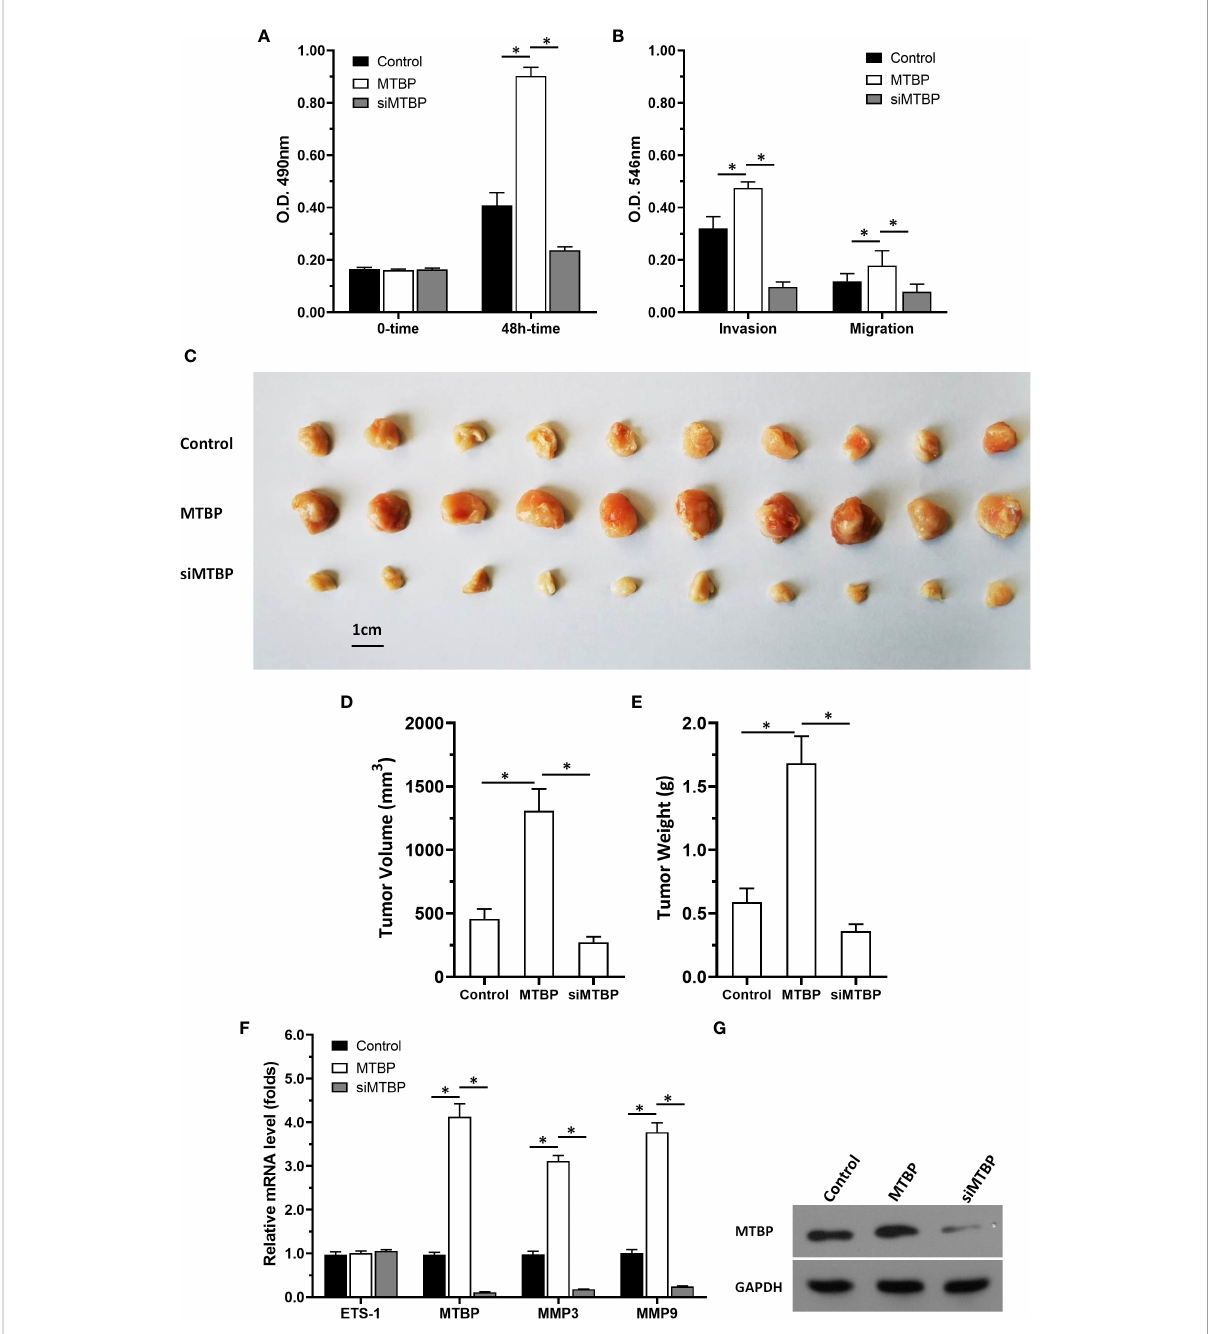
FIGURE 13 MTBP promotes the in vitro or in vivo proliferation of Huh-7 cells. Huh-7 cells were stably transfected with control, MTBP or siMTBP. (A) Huh-7 cells were analyzed by MTT. (B) Huh-7 cells were analyzed by the transwell. (C – G) Huh-7 cells were injected into the nude mice to form the subcutaneous tumor model. The results were shown as images of the tumors (C) , tumor volumes (D) , tumor weights (E) , the mRNA level of MTBP, ETS-1, mmp3, mmp9 in tumor tissues via qPCR. (F) the images of western blot to indicated the stable transfection of MTBP or siMTBP in Huh-7 cells. *P <